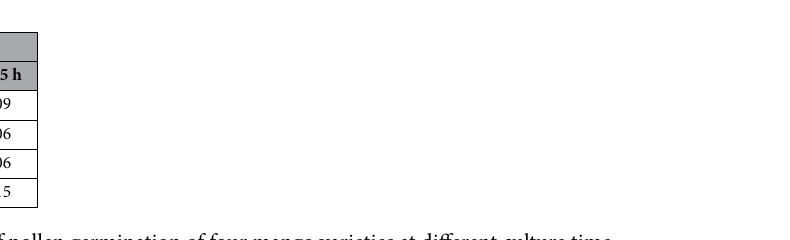
Table 3. Growth rate of pollen germination of four mango varieties at different culture time.